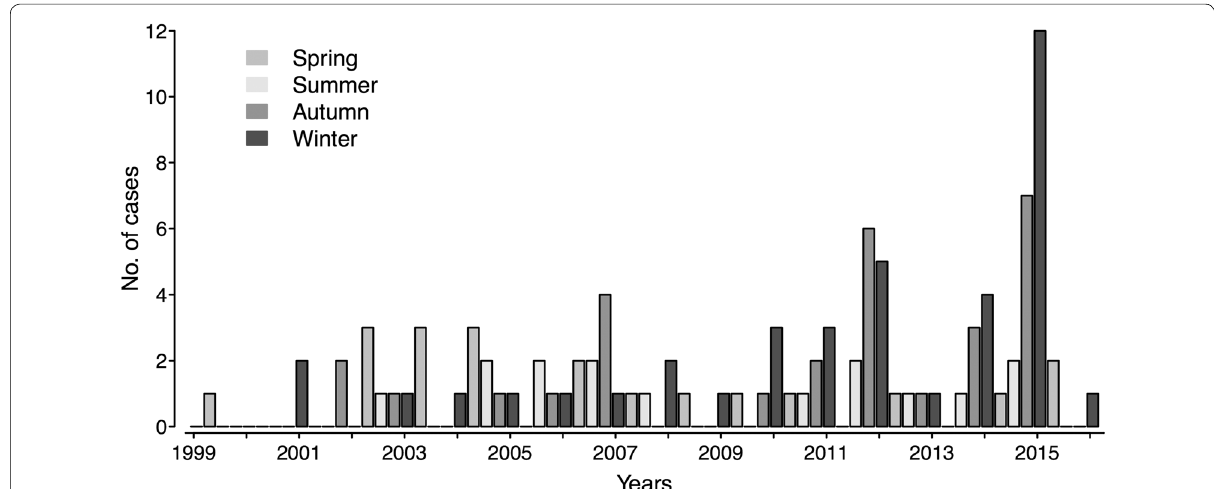
Fig. 1 Distribution of atypical pneumonia cases by season and